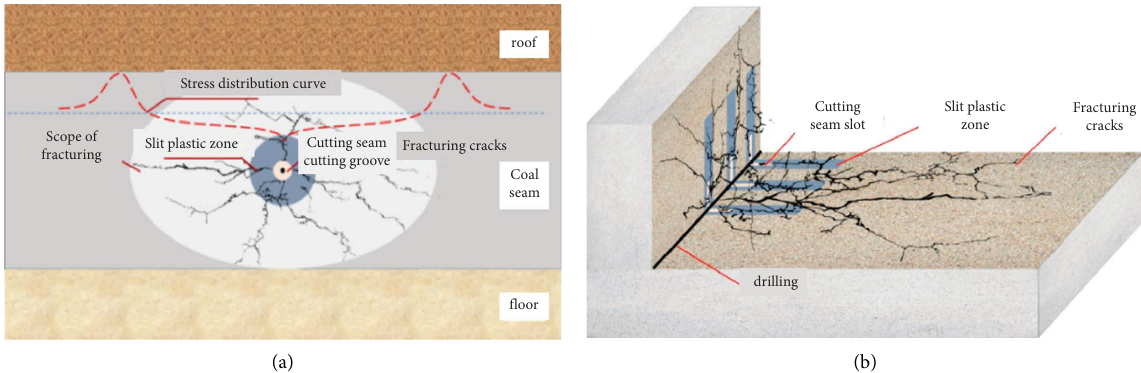
Figure 1: Schematic diagram of high efciency anti-penetration mode of cutting before pressing. (a) Schematic diagram of fracture propagation profle after cutting. (b) Schematic diagram of the distribution plane of the slit after cutting.